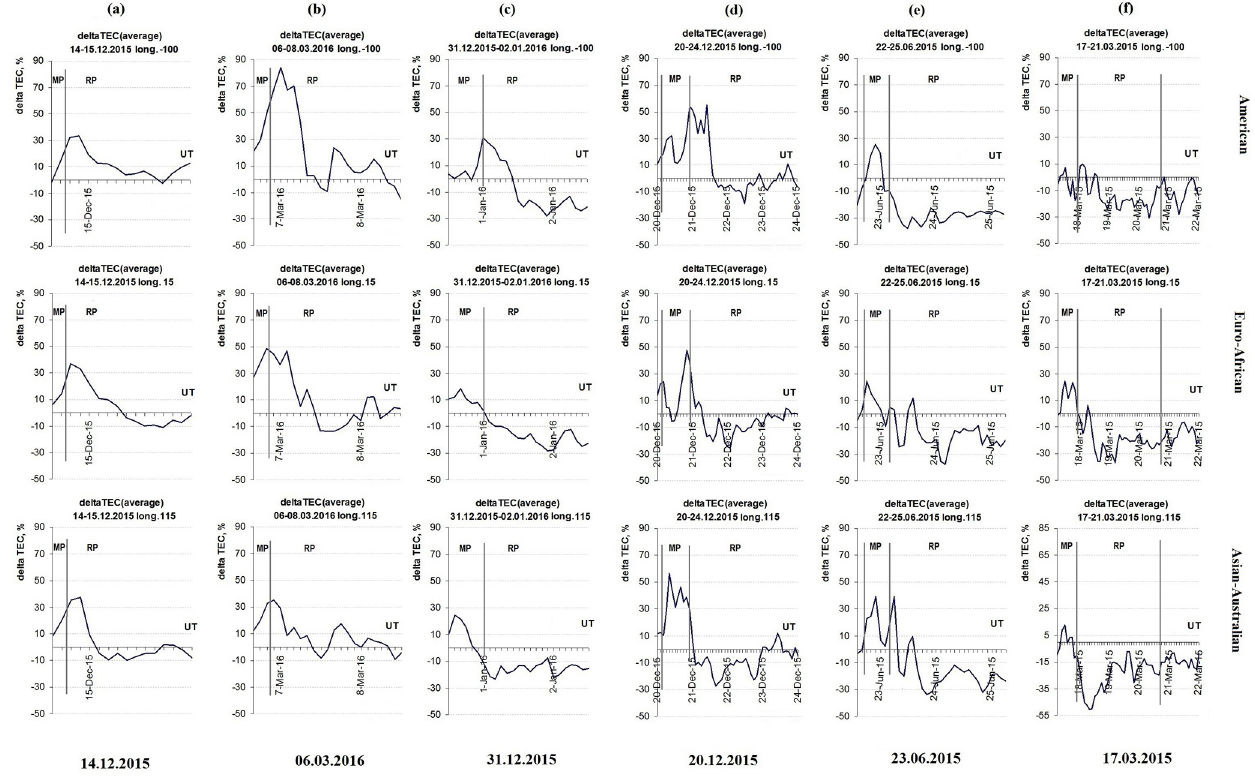
Figure 5. δ TEC averaged along each meridian during the storms. Vertical lines indicate the periods of MP and